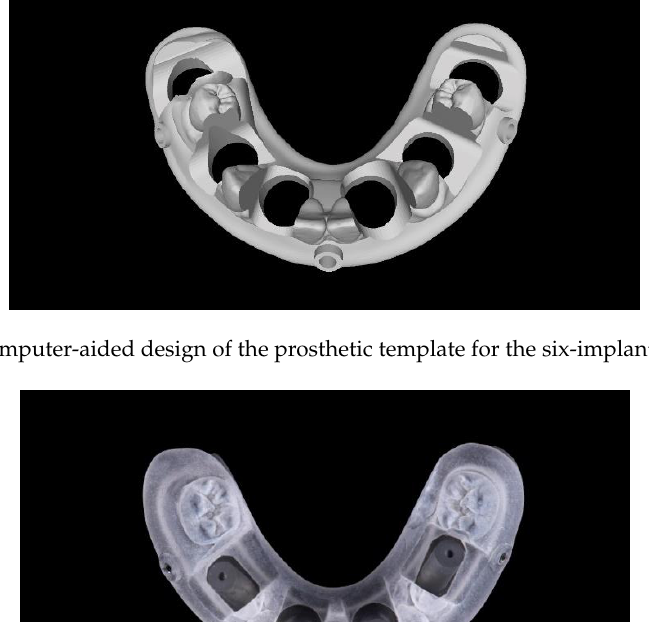
Figure 7. Titanium model (four implants) with a prosthetic template screwed.